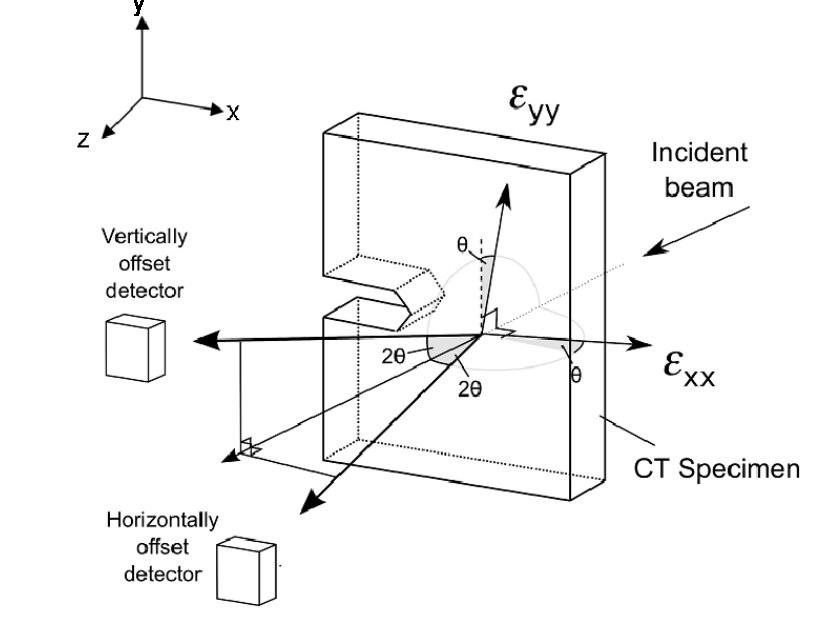
Figure 2: Schematic of the diffraction geometry showing a CT specimen with the crack plane horizontal, and the two detectors measuring two directions of strain; note the coordinate system for ε xx and ε yy adopted after [4]. For very low  these strains can be taken as representative of those in the loading (y) and crack growth (x) directions.